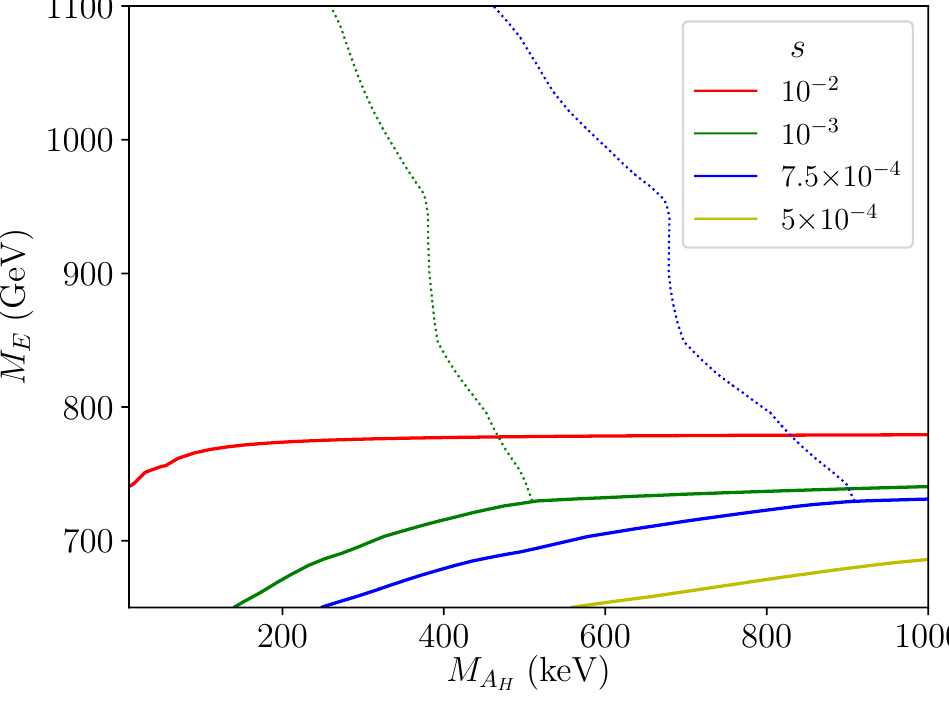
√ s = 13 TeV and L = 3 ab − 1 , on models